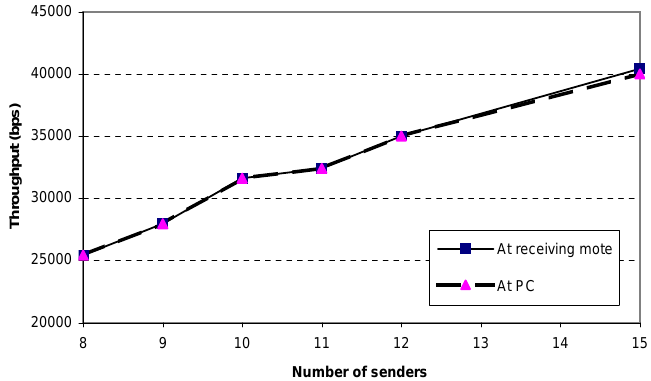
Figure 9. Aggregate throughput at receiving mote and PC as a function of the number of senders (sending rate = 4